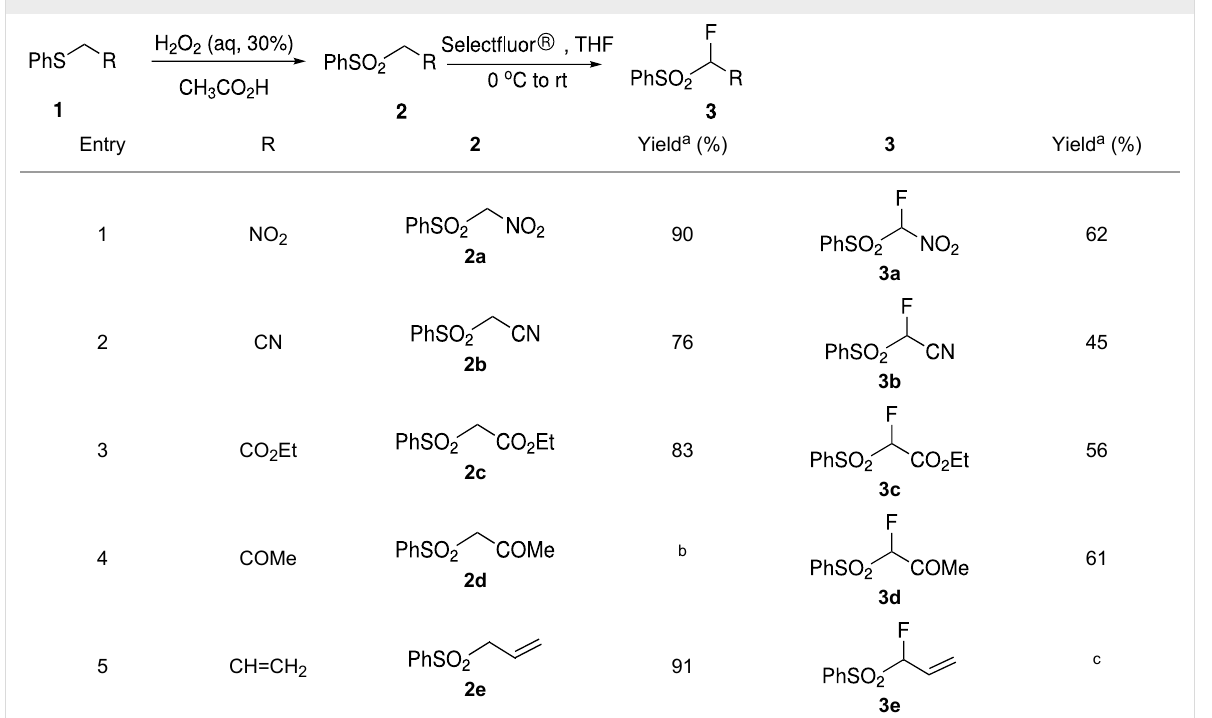
Table 1: Oxidation of sulfides and monofluorination of